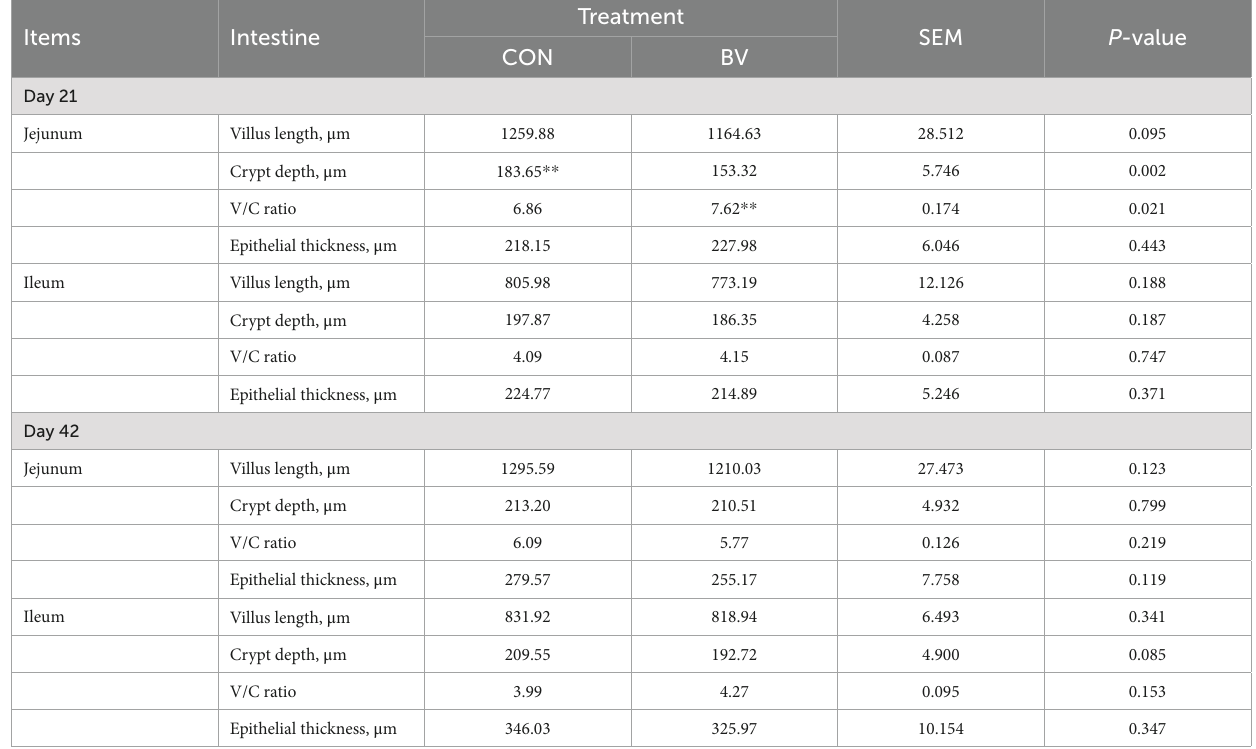
TABLE 5 Effect of Bacillus velezensis LB-Y-1 on histomorphology of the small intestinal sections in broilers ( n = 6).